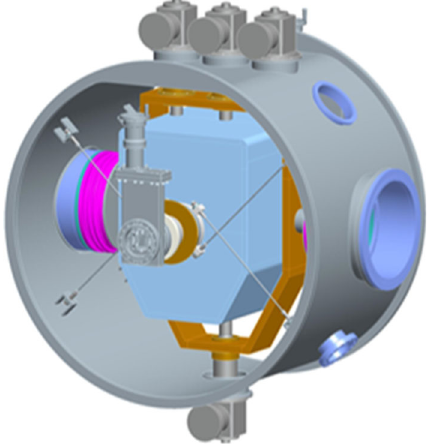
FIG. 21. Cryomodule with cryocoolers, FPC top hats and inner magnetic shield